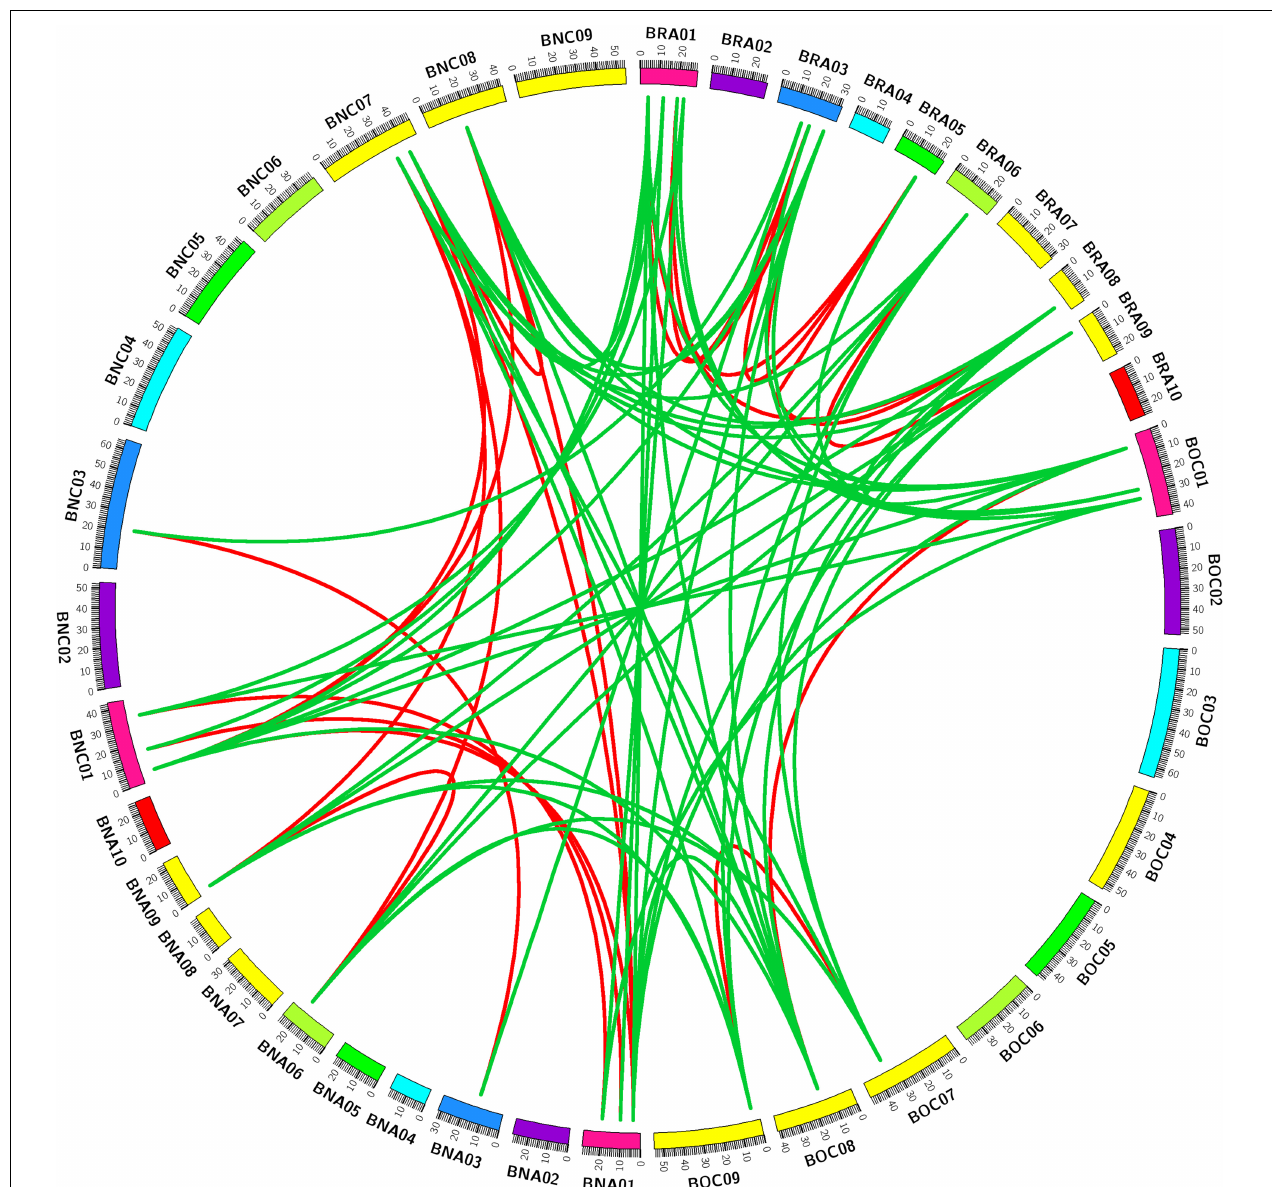
FIGURE 1 | Synteny analysis of CPP genes in genomes of B. rapa , B. oleracea, and B. napus . Red lines and green lines separately linked the syntenic paralogs and orthologs. BRA01–10, ten chromosomes in B. rapa ; BOC01–09, nine chromosomes in B. oleracea ; BNA01–10, ten chromosomes in A n sub-genomes in B. napus ; BNC01–09, nine chromosomes in C n sub-genomes in B. napus